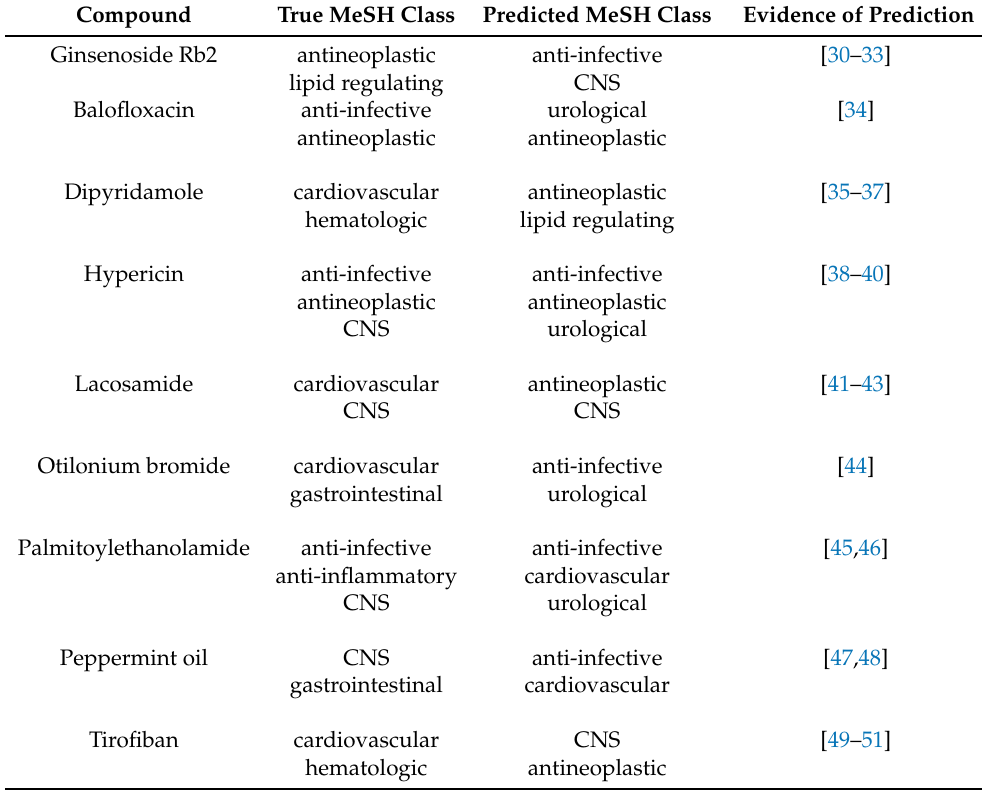
information in the literature. The ‘True MeSH Class’ column provides the list of MeSH classes to which the drug compound belongs, as given in the PubChem data. On the other hand, the ‘Predicted MeSH Class’ column provides the list of MeSH classes our model predicted for each drug compound. The literature that concurs with these predictions is provided in the ‘Evidence of Prediction’